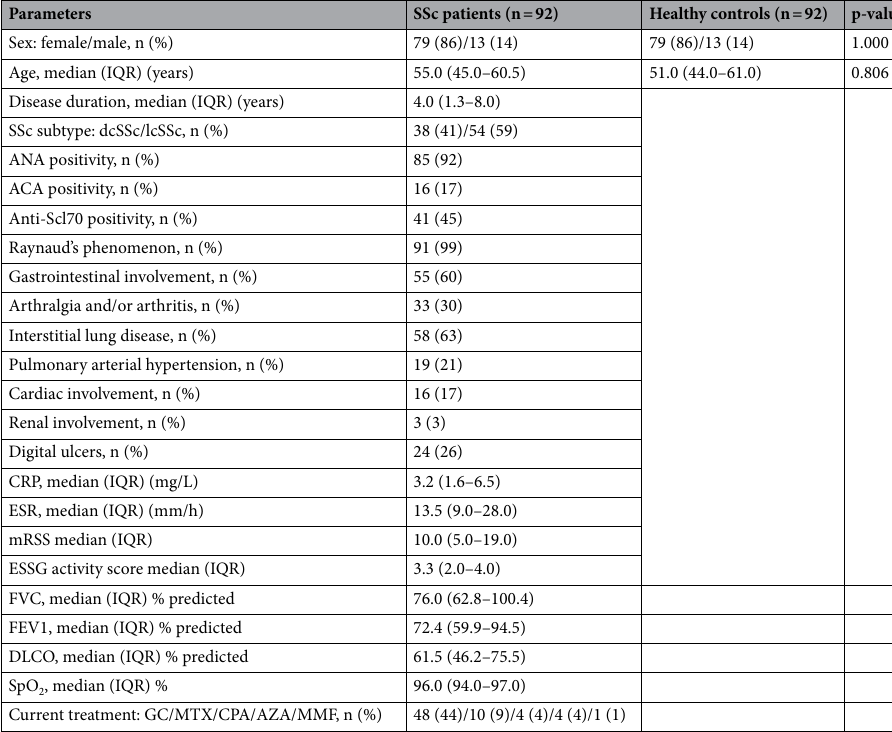
Table 1. Clinical and demographic characteristics of SSc patients and healthy controls: cross-sectional analysis. SSc systemic sclerosis, lcSSc limited cutaneous SSc, dcSSc diffuse cutaneous SSc, IQR interquartile range, ANA antinuclear antibodies, Anti-Scl-70 anti–DNA-topoisomerase I antibodies, ACA anticentromere antibodies, ESSG European Scleroderma Study Group, mRSS modified Rodnan skin score, CRP C-reactive protein, ESR erythrocyte sedimentation rate, FVC forced vital capacity, FEV1 forced expiratory volume in 1 s, DLCO diffusing capacity for carbon monoxide, SpO 2 blood oxygen saturation level, GC low dose glucocorticoids (i.e. ≤ 10 mg/day of prednisone), MTX methotrexate, CPA cyclophosphamide, AZA azathioprine, MMF mycophenolate